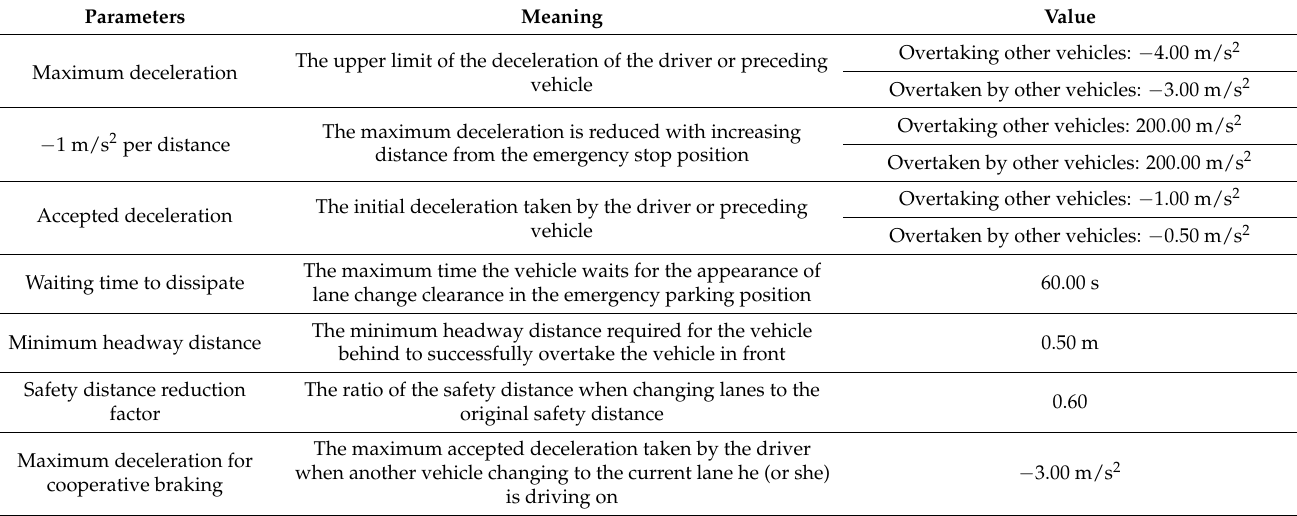
Table 3. The meanings and values of the parameters of the vehicle lane changing